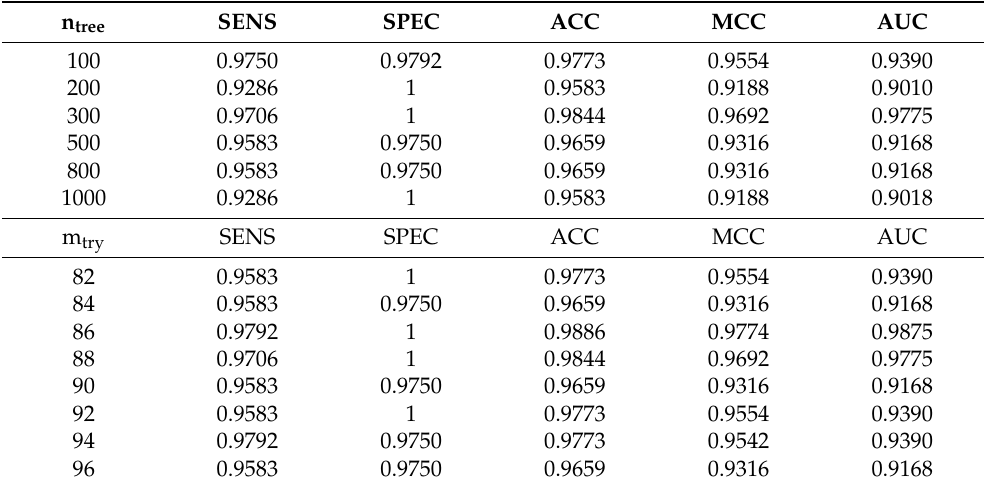
Table 4. The parameter screening in the RF model for variables is ranked by permutation accuracy